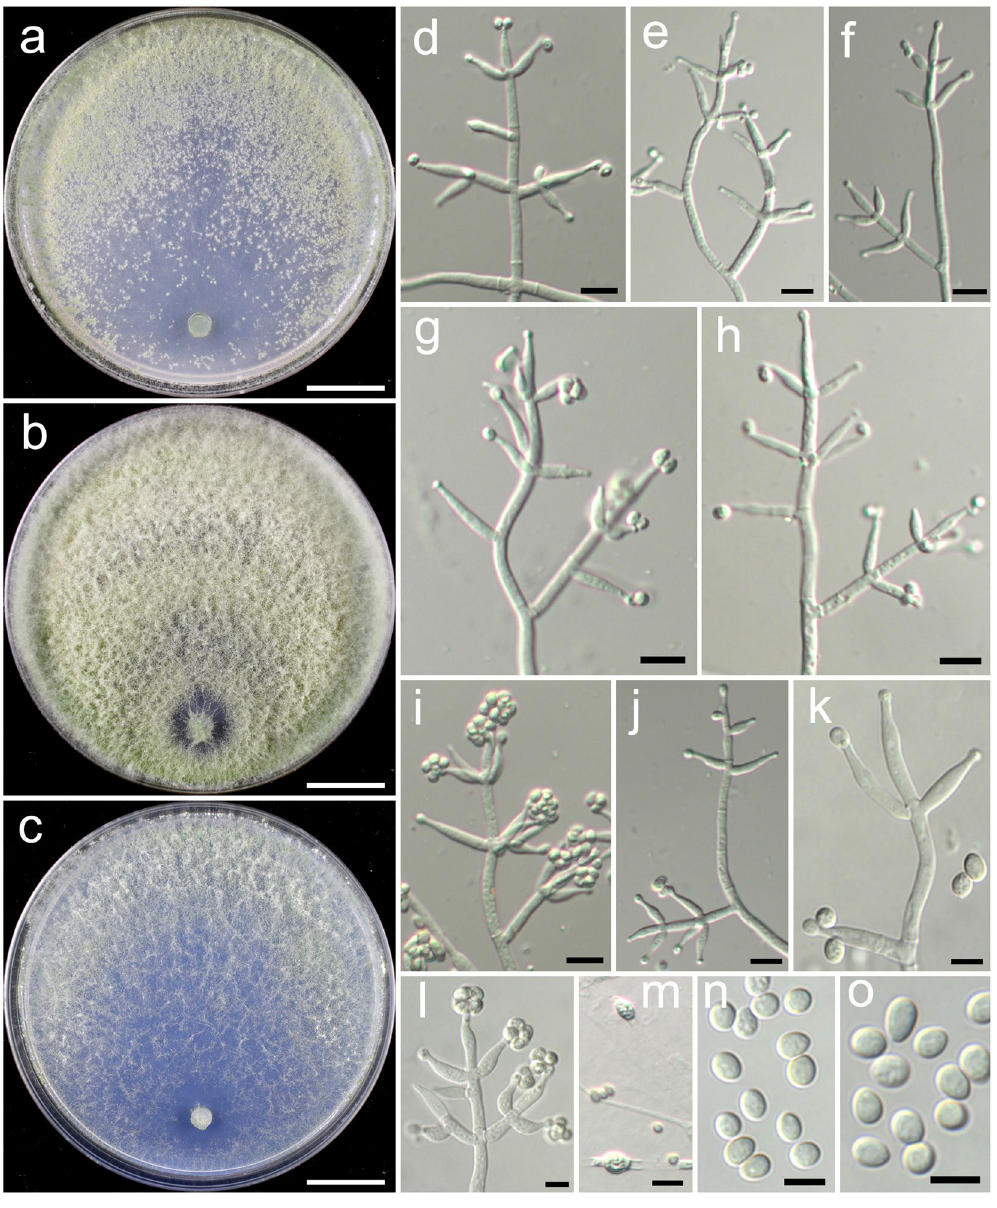
Figure 21. Trichoderma simplex (HMAS 248842). ( a – c ) Cultures at 25 °C, 7 d (a. on CMD; b. on PDA; c. on SNA); ( d – l ) Conidiophores and phialides (PDA, 4 d); ( m ) Chlamydospores (SNA, 7 d); ( n , o ) Conidia (PDA, 4 d). Bars: a–c = 20 mm. d–j, m = 10 μ m. k, l, n, o = 5 μ